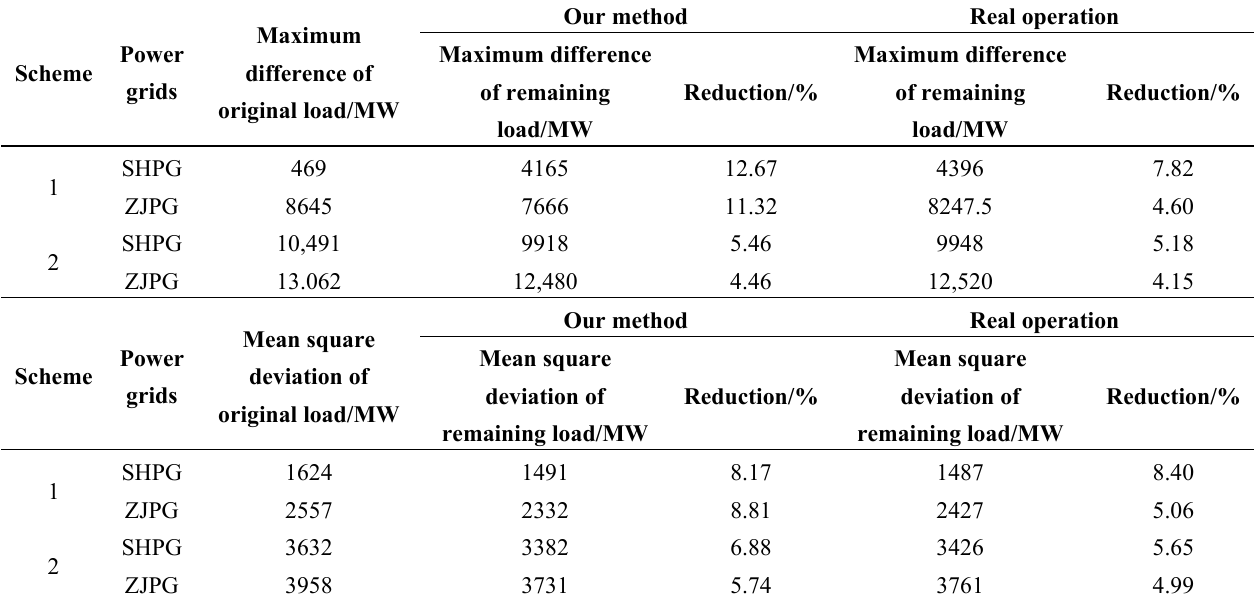
Table 2. Comparison of the optimal results from two